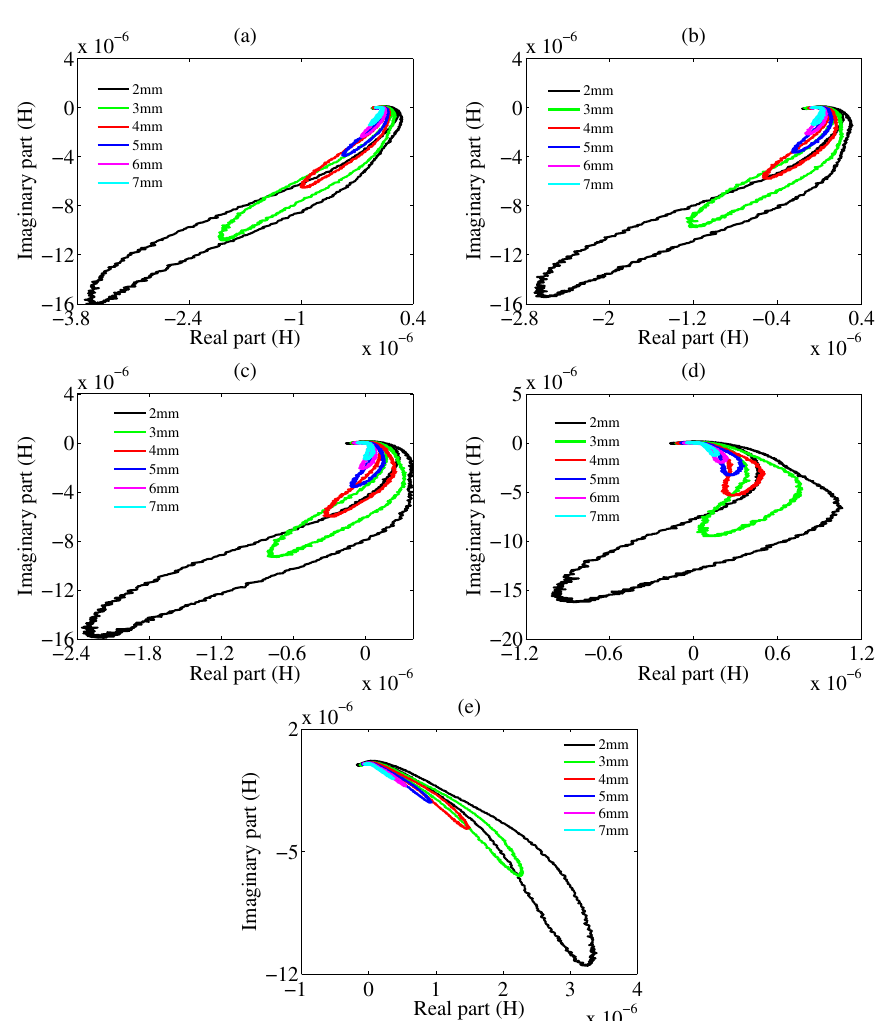
Figure 7. Measured mutual inductances in the form of the real part and the imaginary part for tilting samples with variable lift-off. ( a ) Cu. ( b ) Al. ( c ) Zn. ( d ) Sn. ( e )